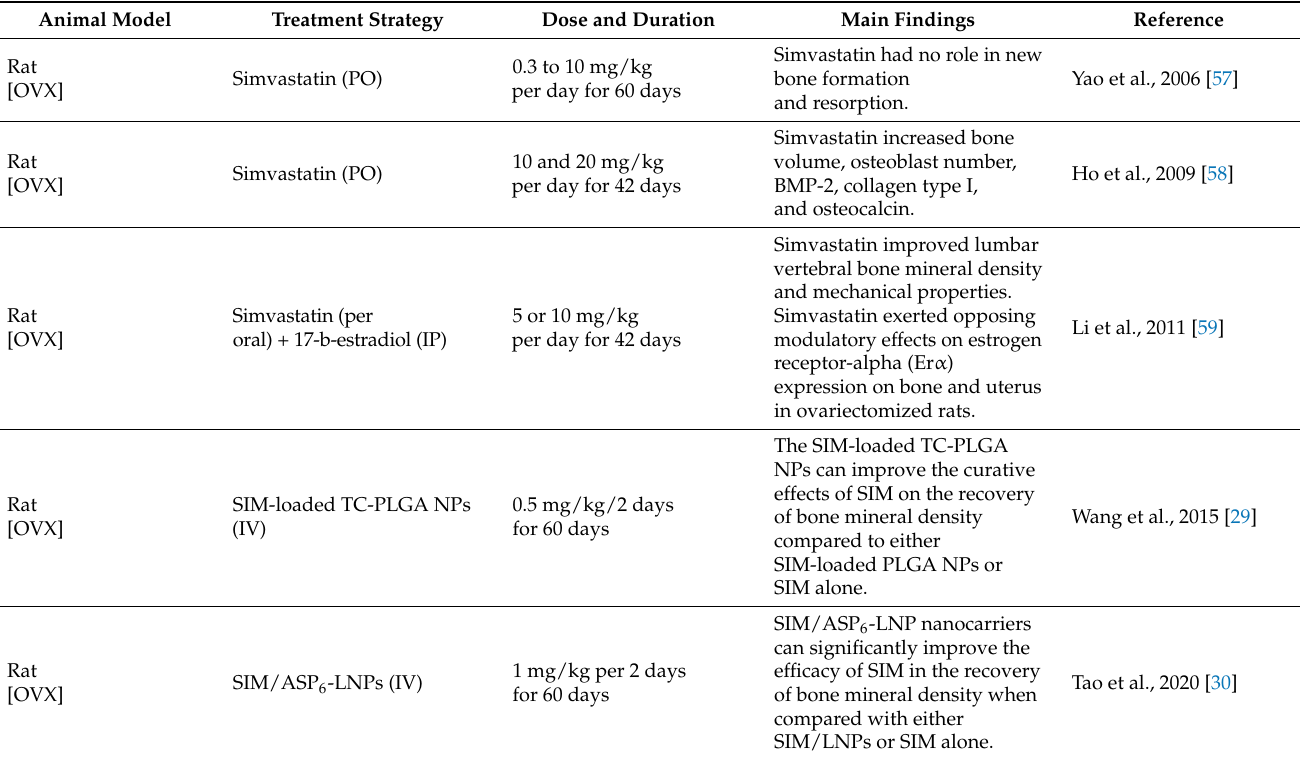
Table 3. In vivo investigations used systemic delivery of SIM and SIM nanocarriers in experimental models relevant to osteoporosis or